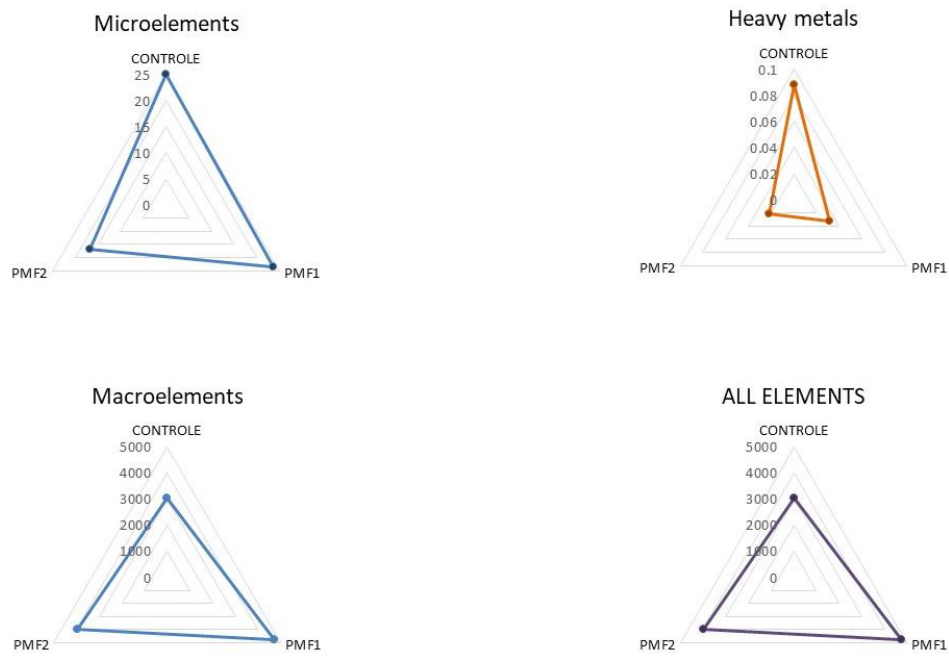
Figure 7. Changes in micro–macro elements and heavy metals and the sum thereof under the influence of the application of doses of pulsating magnetic field for radish sprouts.